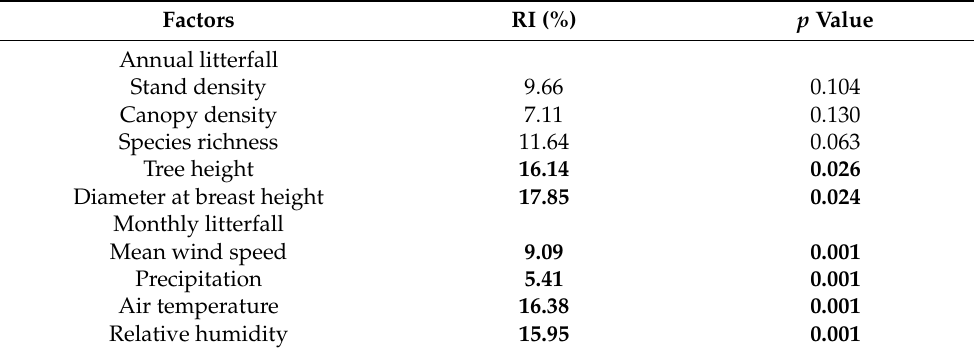
Figure 6. Relationships of vegetation factors with annual litterfall production ( a ) and of climate factors with monthly litterfall production ( b ) based on redundancy analysis (RDA). The data used in this analysis were the litterfall from the three plantations. Table 2. The relative influences (RI%) of vegetation factors on annual litterfall and of climate factors on monthly litterfall and their p values based on redundancy analysis and hierarchical partitioning analysis.